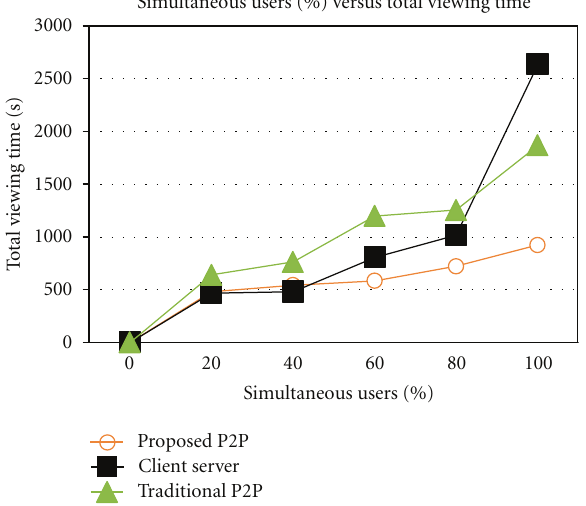
Figure 6: Percentage of simultaneous users versus start-up